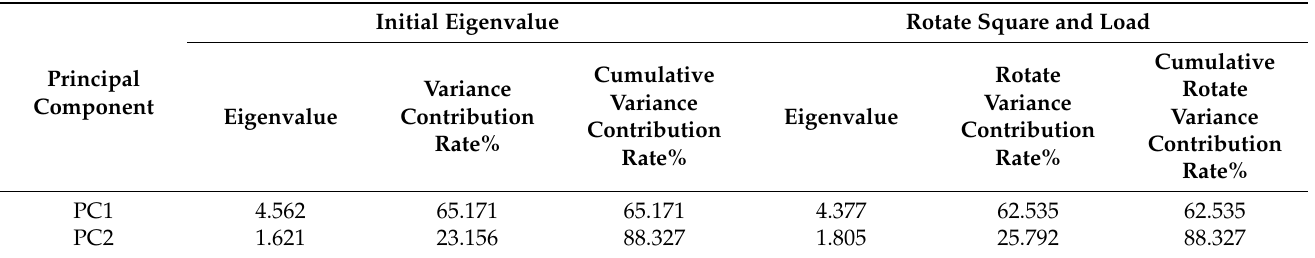
Table 6. Fatty acid characteristic value and the variance contribution rate of fresh sweet-waxy corn in the regions.